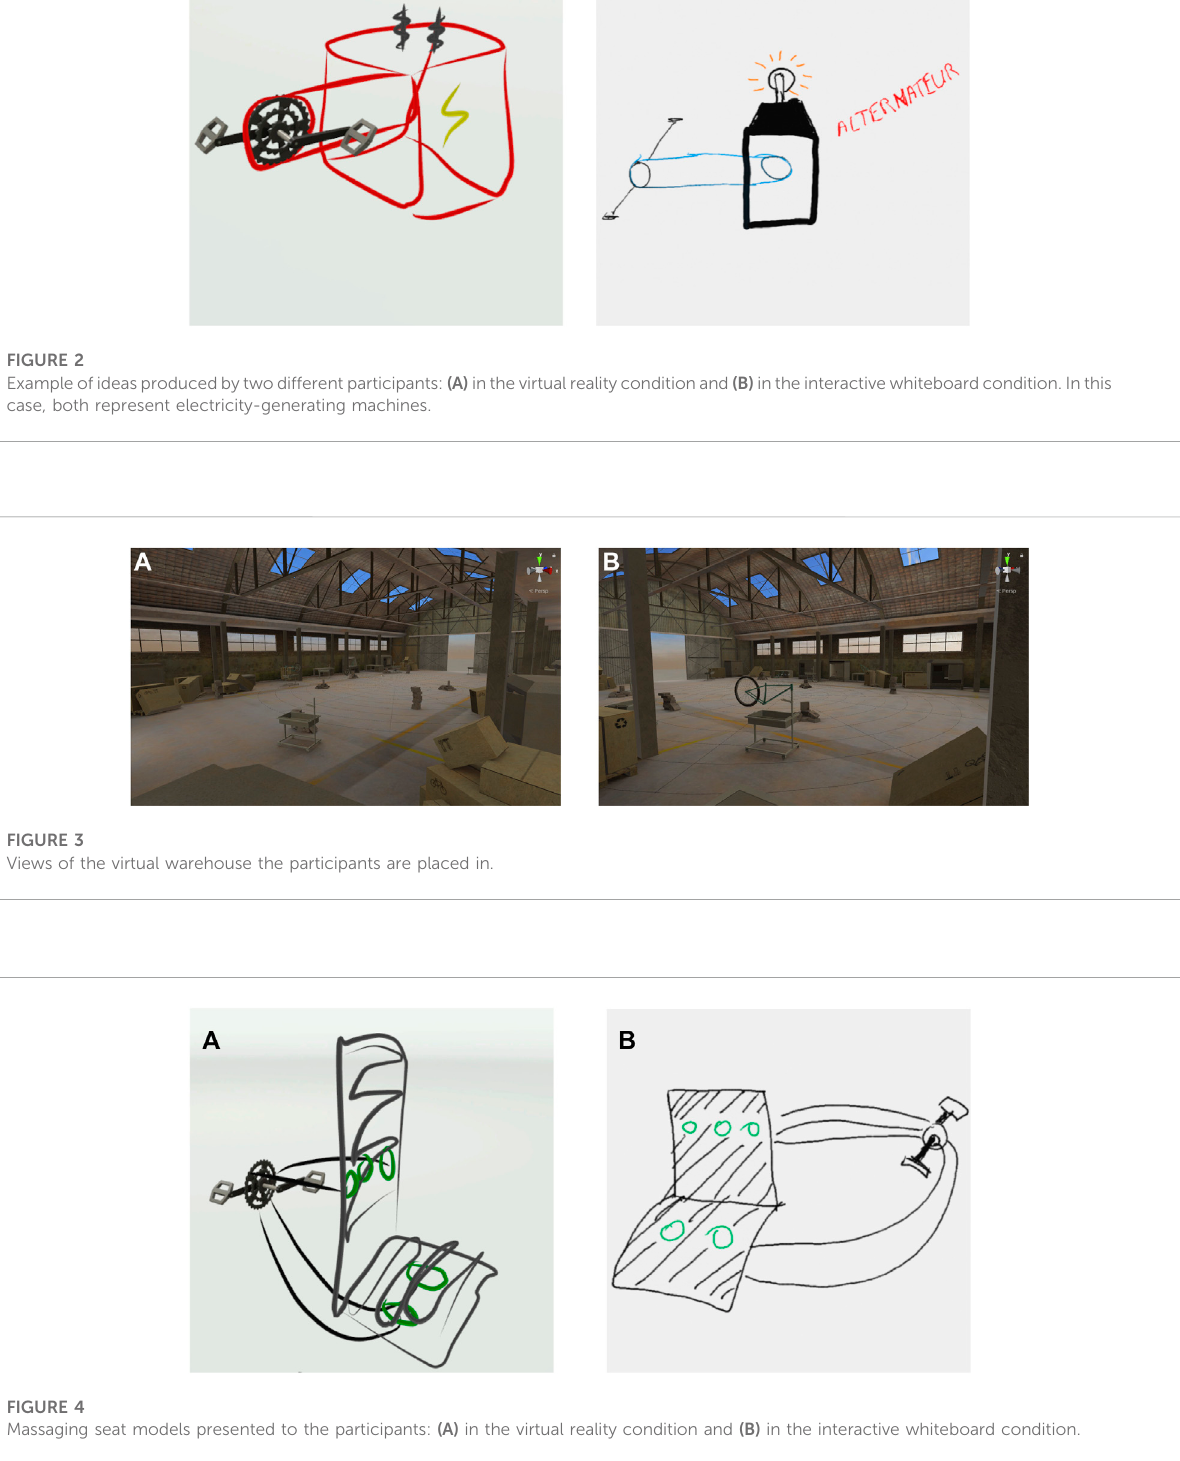
Frontiers in Virtual